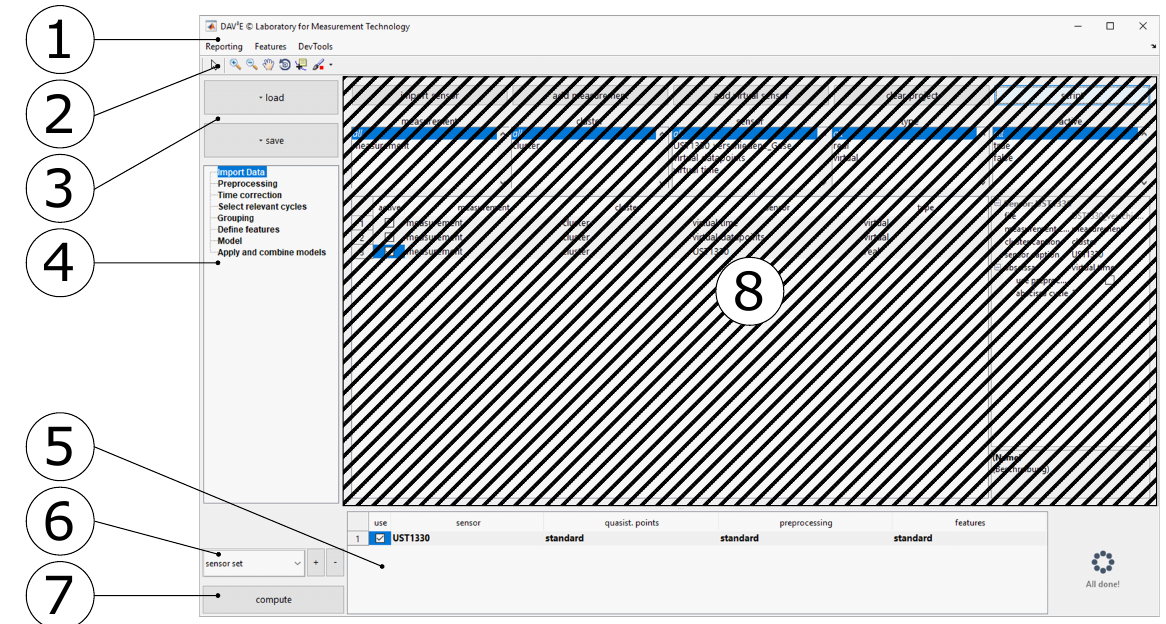
Figure 3. Main GUI with menu bar (1), toolbar (2), load and save buttons (3), the list of modules (4), the list of selected sensors (5), the current sensor set (6), the compute button for features (7), and the currently selected module (8,